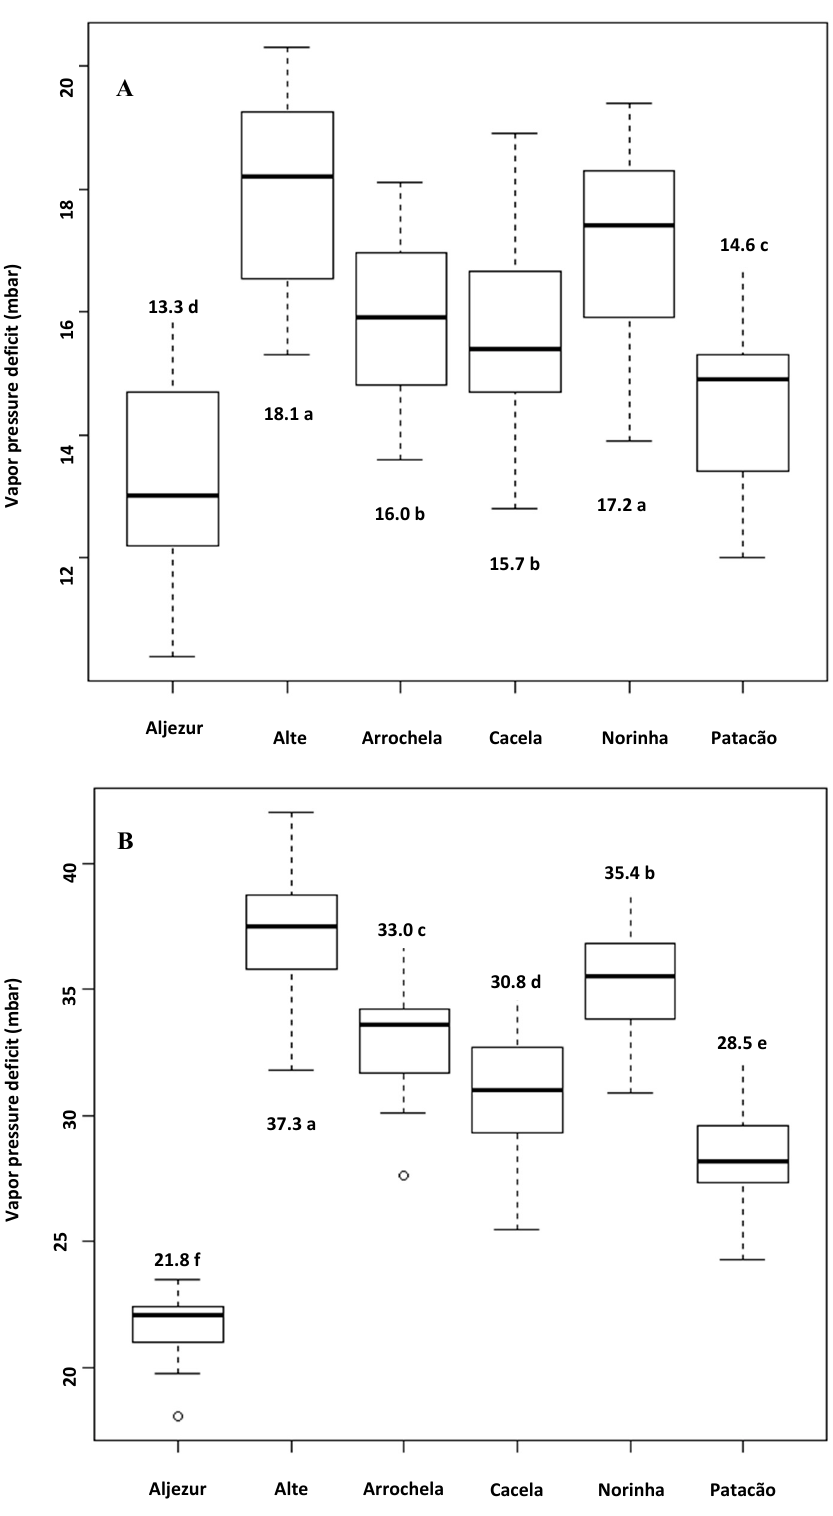
Figure 3. Box-plot graphs of mean water vapor pressure deficits in six zones of Algarve in the spring ( A ) (February to May) and summer ( B ) (June to September) from 2004 to 2018 (ANOVA: February to May, F = 17.91, p < 0.001; June to September. F = 84.00, p < 0.001). Highlighted means with the same letters were not different by Scott – Knott grouping test ( p < 0.05).